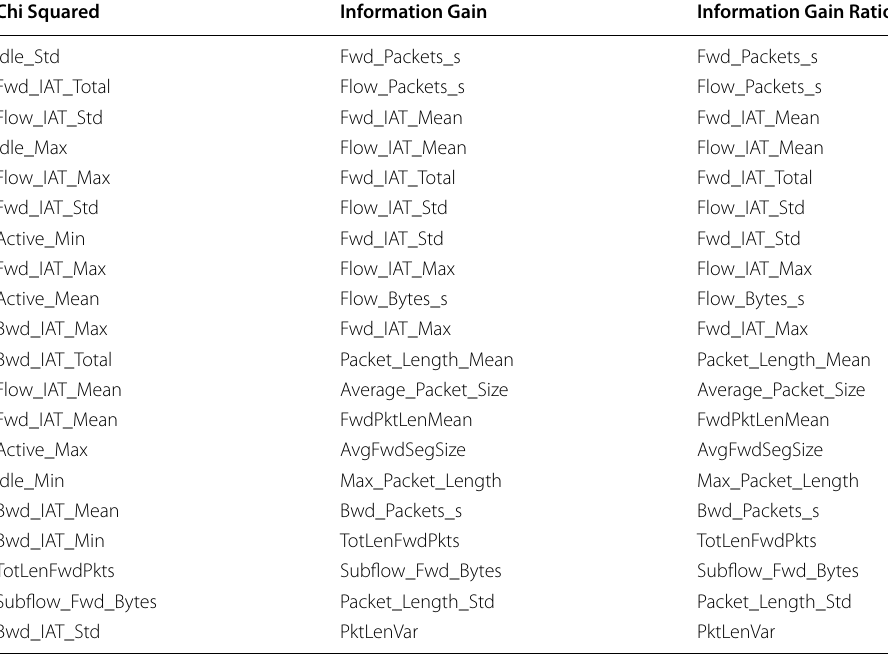
Table 14 Top 20 features for Brute Force Web Attacks ranked by Filter-based techniques Chi Squared